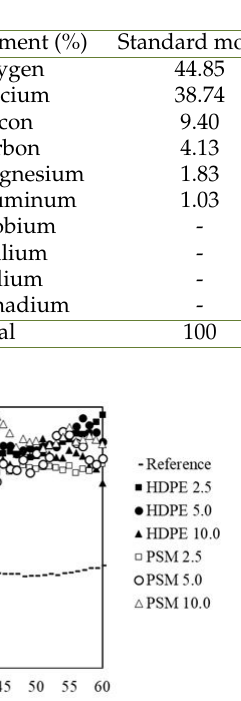
Table 3. Elemental chemical composition of standard mortar and plastic wastes used